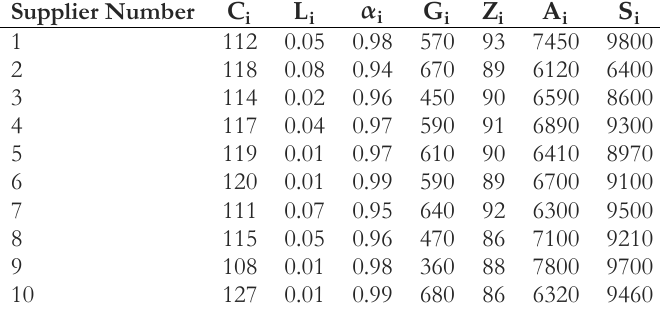
Table 2. The parameters of the